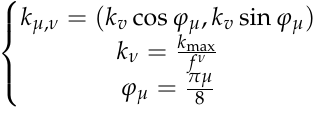
Figure 5. Spectrum pretreated by SNV and MSC.